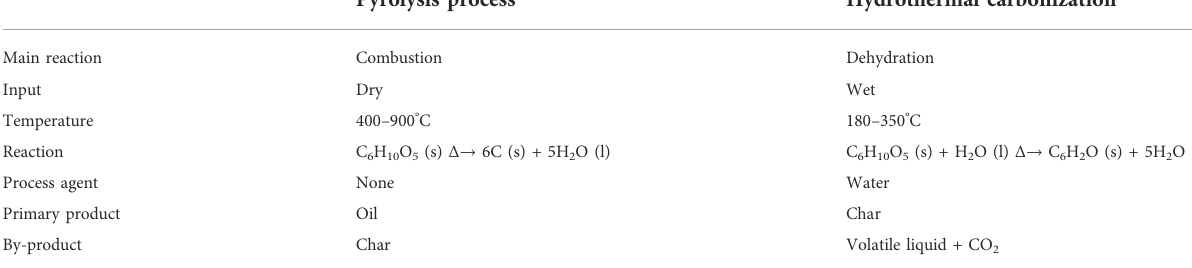
TABLE 5 Summary of the comparison between pyrolysis and hydrothermal carbonization (Khan T. A. et al.,